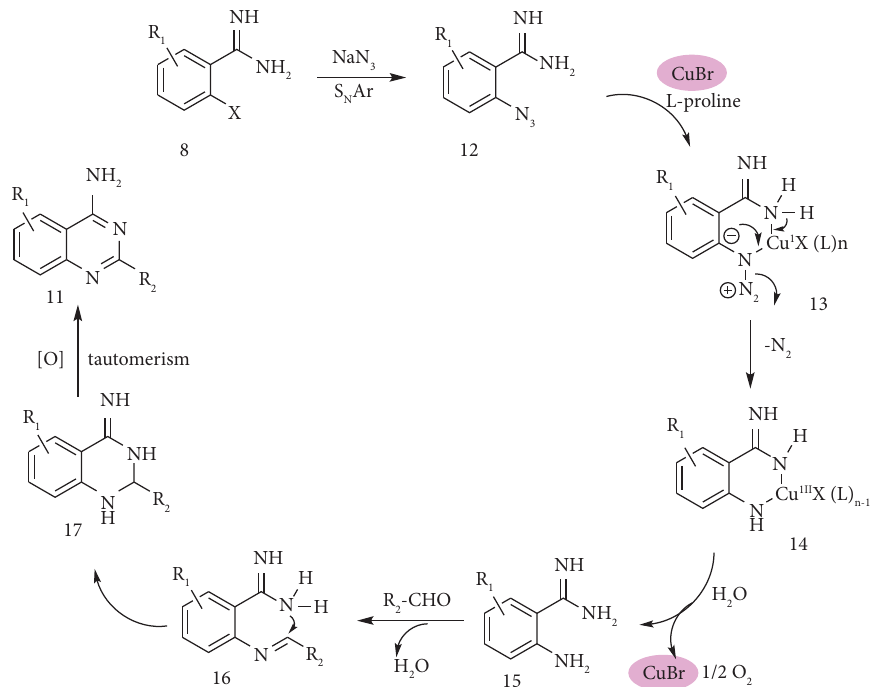
Figure 4: Te proposed mechanism for the synthesis of 2-substituted-4-aminoquinazoline derivatives in the presence of CuBr, L-proline, and